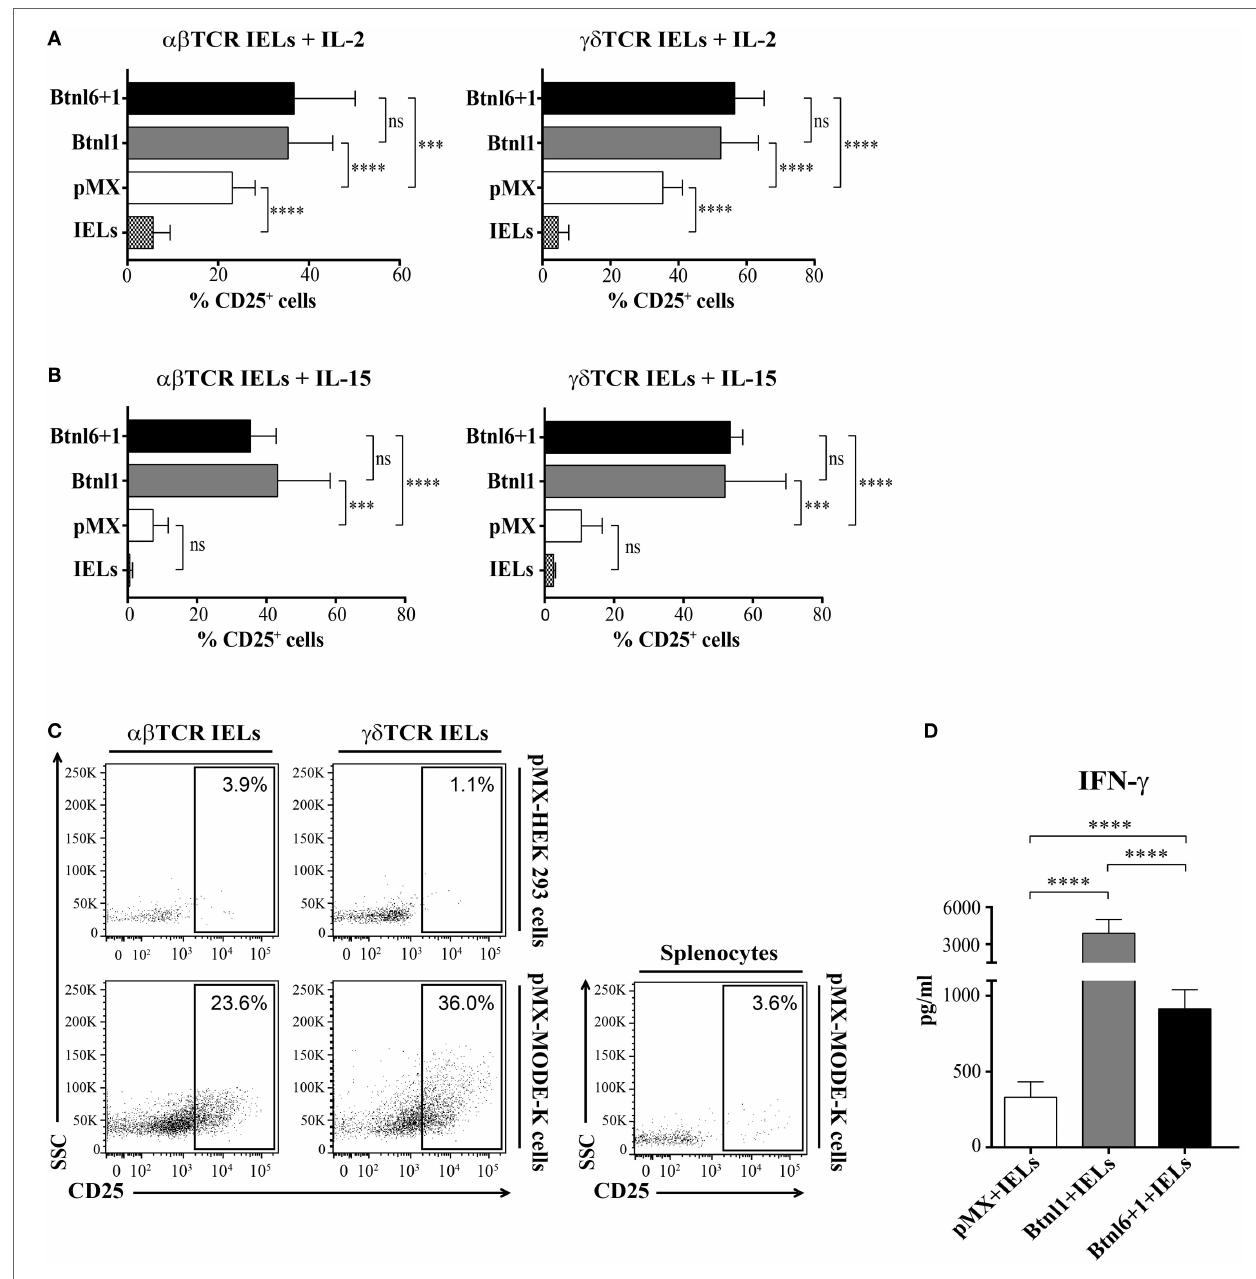
FigUre 6 | Btnl proteins induce cD25 expression. (a,B) MODE-K cells transfected with Btnl6 and Btnl1 cDNA pMX-IRES-GFP, Btnl1 cDNA pMX-IRES-GFP, or empty vector (pMX-IRES-GFP) were cocultured with IELs without anti-CD3 activation in the presence of IL-2 (a) or IL-15 (B) . CD25 expression was assessed on gated αβ TCR and γδ TCR IELs, after gating on LIVE/DEAD Fixable Red negative cells to exclude non-viable cells subsets and on CD45 + to exclude GFP + MODE-K cells, after 96 h. Graphs show the mean ± SD, and data are pooled from seven independent experiments, each in duplicates, for IL-2, and two independent experiments, each performed in triplicates, for IL-15. (c) Culture of total IELs or splenocytes, without anti-CD3 in the presence of IL-2, with HEK 293 cells or MODE-K cells transfected with empty vector (pMX-IRES-GFP). Splenocytes and IELs gated on αβ TCR or γδ TCR IEL subsets, after gating on LIVE/DEAD Fixable Red negative cells to exclude non-viable cells subsets and on CD45 + to exclude GFP + MODE-K cells, were analyzed for CD25 expression after 96 h. Plots shown are representative of seven independent experiments for IELs and MODE-K cells, and of two independent experiments for IELs and HEK 293 or splenocytes and MODE-K cells. (D) Culture of total IELs, without anti-CD3 in the presence of IL-15, with MODE-K cells transfected with Btnl-pMX-IRES-GFP or empty vector control (pMX-IRES-GFP). IFN- γ was assessed by cytometric bead array. Bars show the mean ± SD, and data are pooled from two independent coculture experiments, each performed in triplicates. * P ≤ 0.05, ** P ≤ 0.01, *** P ≤ 0.001, and **** P ≤ 0.0001 as determined by unpaired two-tailed t